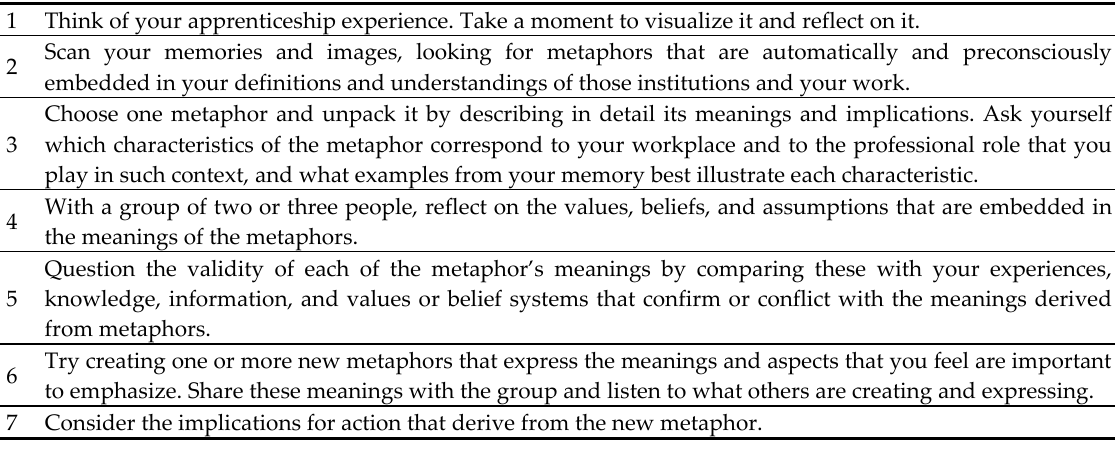
Table 1. The Method of the Analysis of the Metaphor (Deshler,